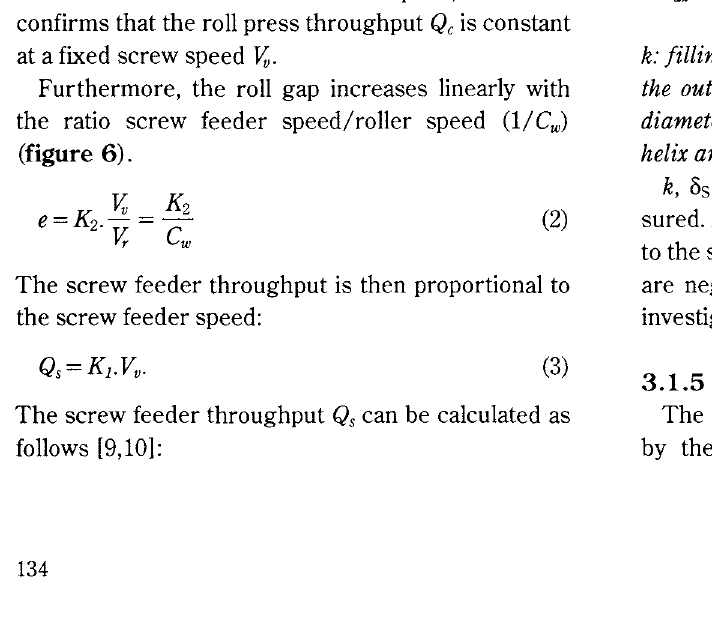
Roll gap versus the ratio screw feeder speed/roller speed